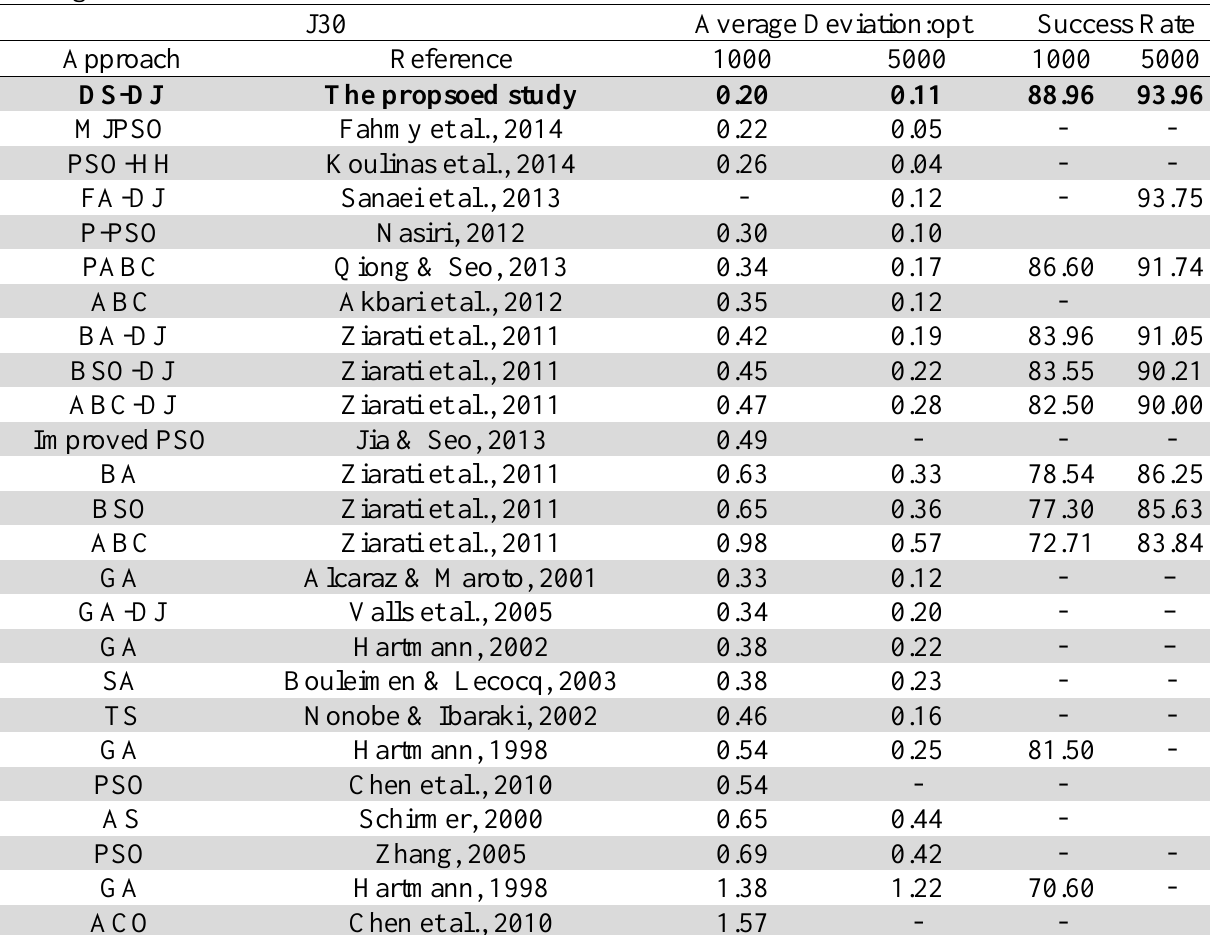
Average deviation and success rates over